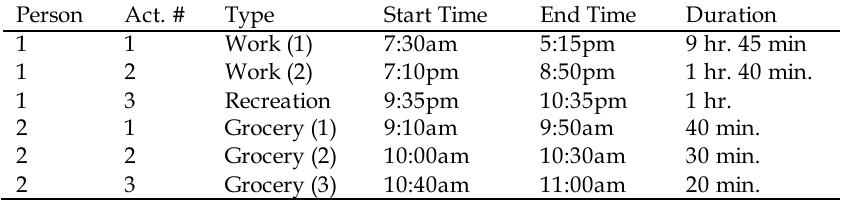
Table 8. Activity List for Example Household with Multiple